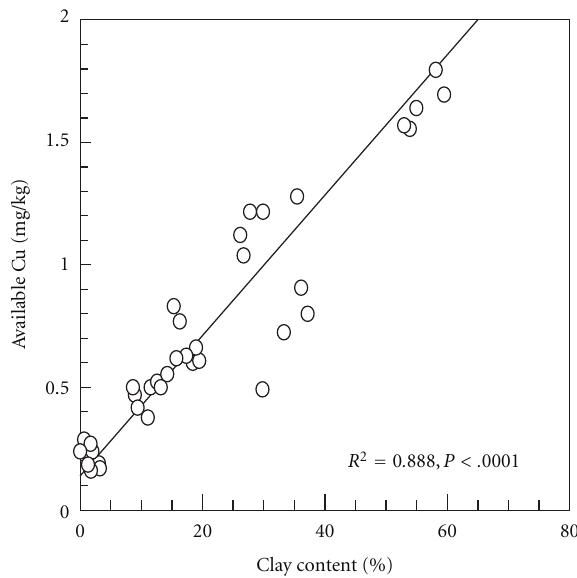
Figure 3: Relationship between clay content and available